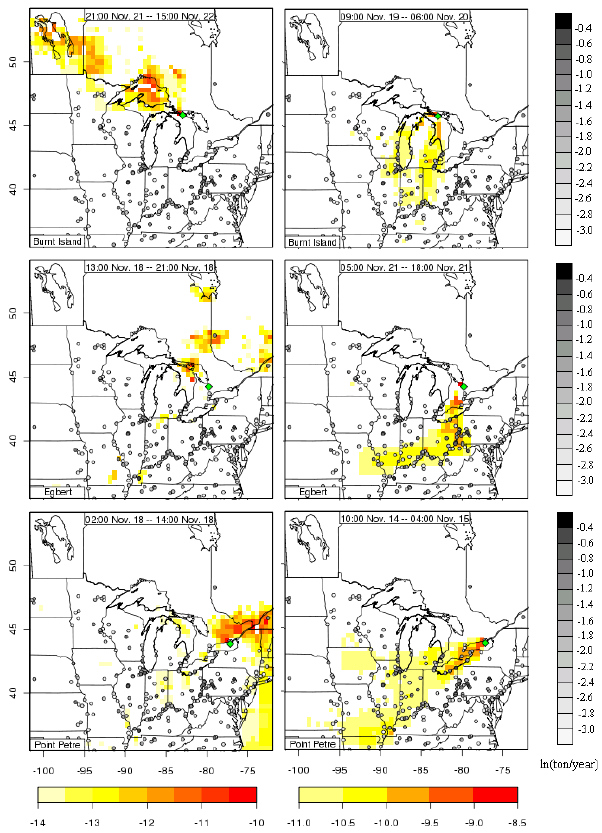
Fig. 10. Similar to Fig. 7: Source contributions [log 10 (ppm)] for the selected Hg plumes (right) and low episodes (left) in 13–22 Novem- ber for Burnt Island (top), Egbert (middle) and Point Petre